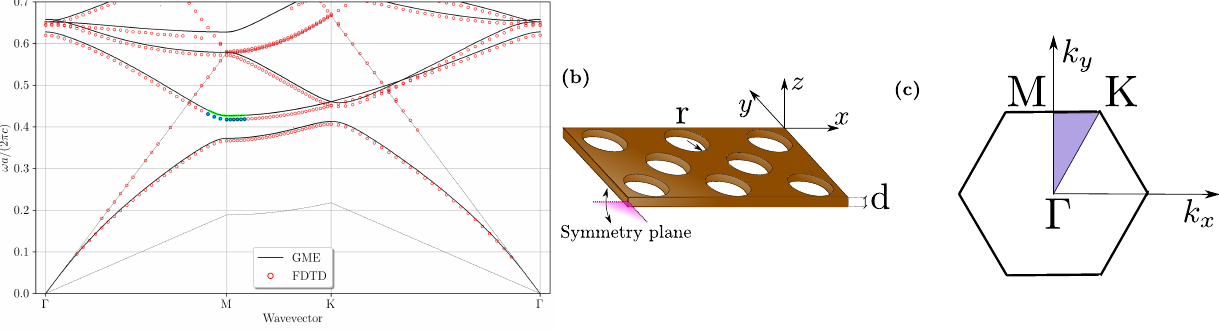
Figure 2. ( a ) Real part of the GaN even modes (transverse-electric (TE)-like) bandstructure calculated with the GME and the FDTD methods, respectively. The parameters chosen for these simulations were: n = 2.28, d / a = 0.337 and r / a = 0.206. The k -space region surrounding of the first-harmonic (FH) mode at the point M is highlighted, and the light lines are dashed. ( b ) Representation of the thin dielectric slab with a triangular photonic lattice, with an indication of the relevant symmetry plane (at z = 0). ( c ) Main symmetry points considered within the Brillouin zone.